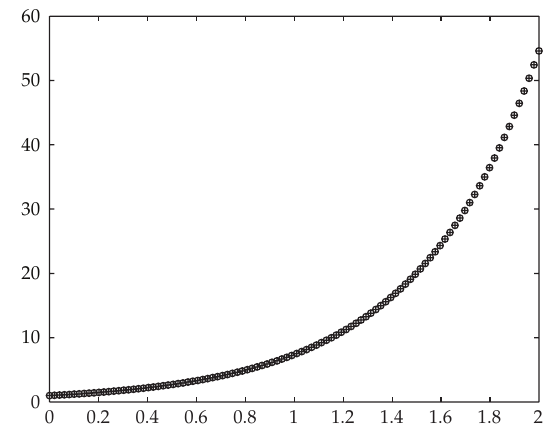
Figure 8: Index 3, T (cid:8) 2, the z 1 -coordinate, “o”-original, “ (cid:9)